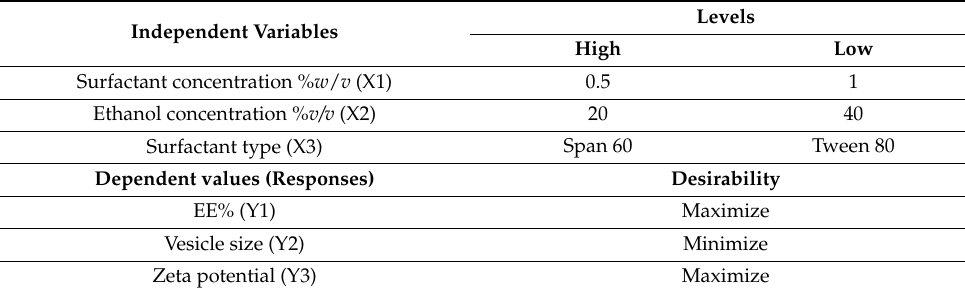
Table 1. I optimal design for optimization of ROS-loaded TESMs.